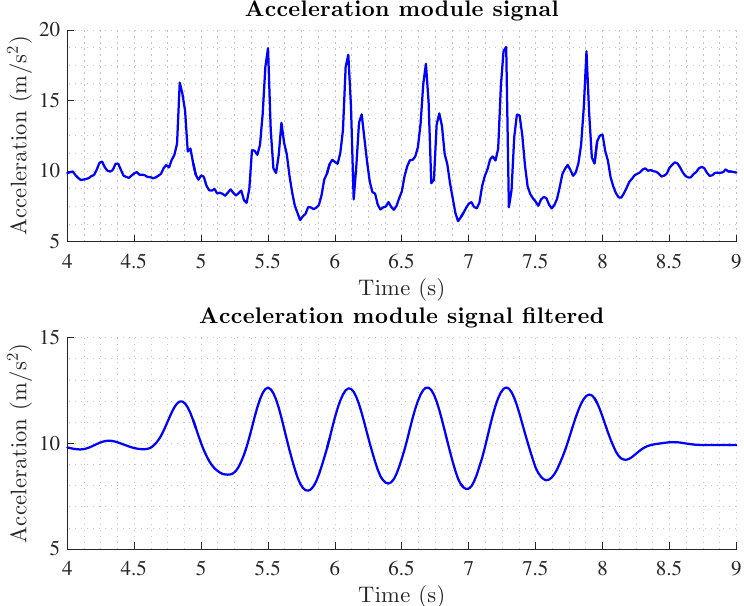
Figure 9. Acceleration signal measured on the hip of a pedestrian during a